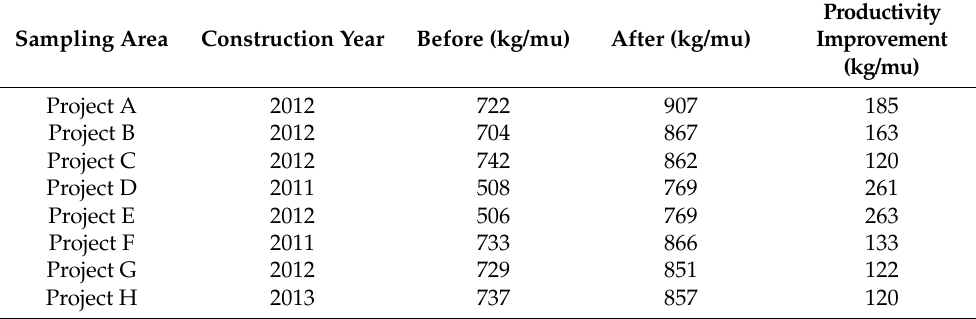
Table 4. Statistics of the improvement level of cropland productivity before and after the construction of sampling project regions.